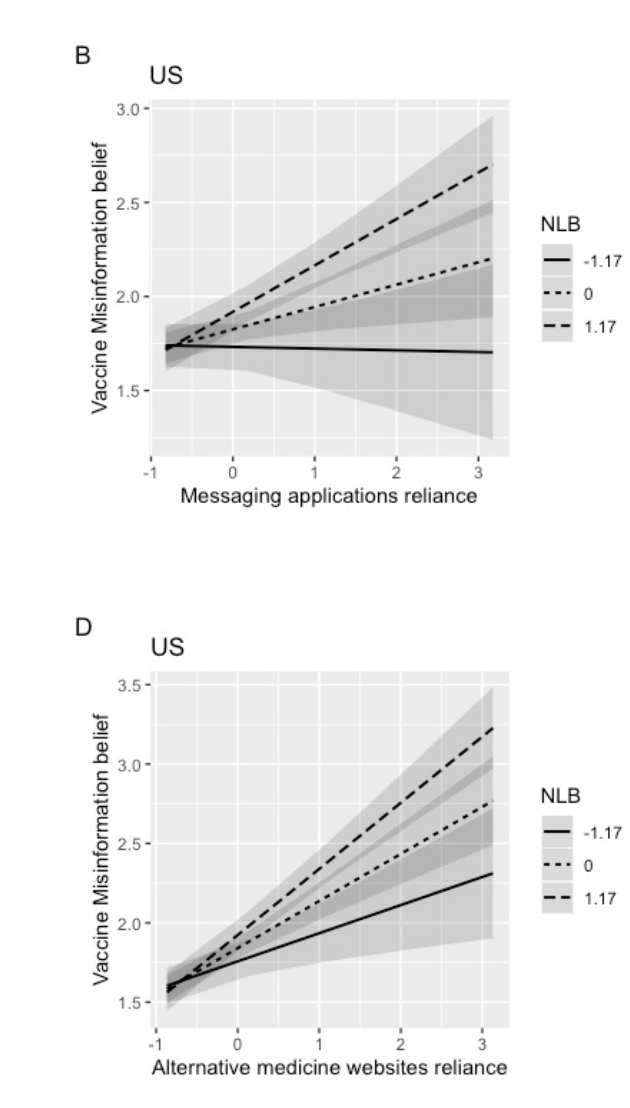
Figure A1. Two-Way Interaction between Media Reliance and NLB on Vaccine-Related Misinformation Belief (US Sample). Plots represent marginal effects at − 1 SD, Mean, and +1 SD. Figures A – D represent the interaction between NLB and reliance on 1) social media, 2) messaging applications, 3) health blogs and 4) alternative medicine website individually.